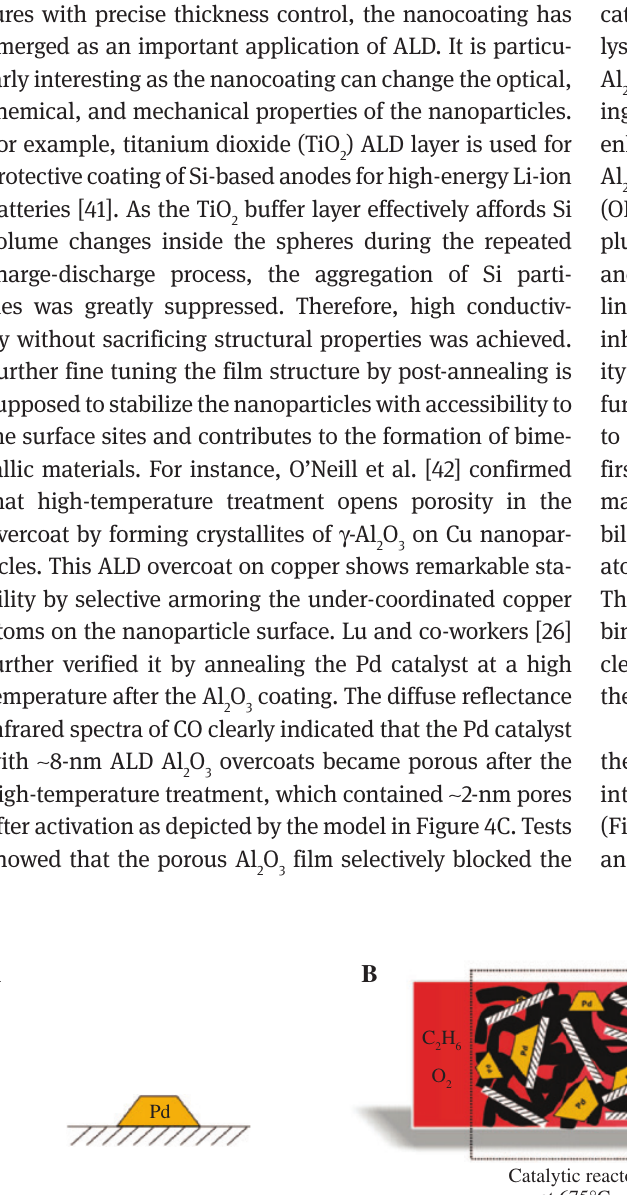
O overcoat during the oxidative dehydrogenation of ethane 2 3 O catalyst during ODHE reaction. (C) The Pd catalyst with an 2 3 O catalyst during ODHE reaction. Reprinted with permission from Ref. 2 3